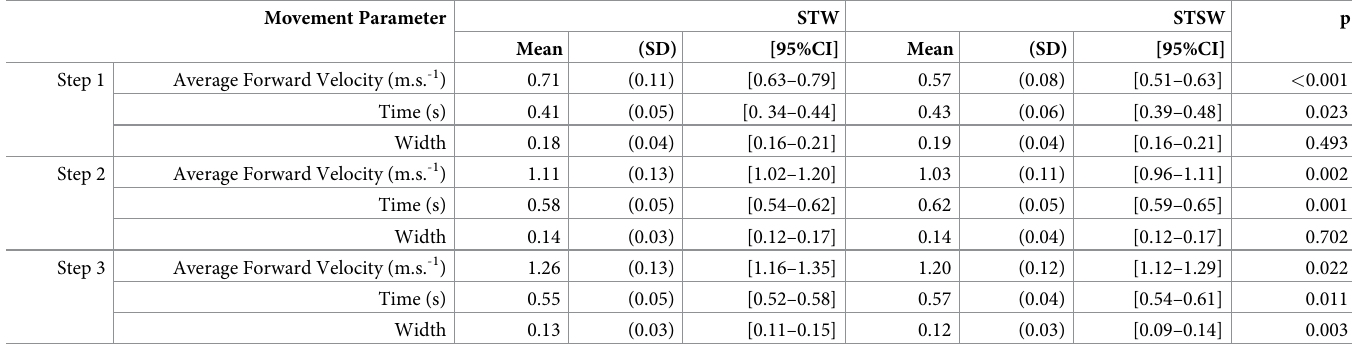
Table 5. Mean (SD) [95%CI] comparison for BCoM forward velocity, stepping time, and step width between STW and STSW. Movement Parameter STW STSW p Mean (SD) [95%CI] Mean (SD) [95%CI] Step 1 Average Forward Velocity (m.s. -1 ) (0.04) 0.493 Step 2 Average Forward Velocity (m.s. -1 )